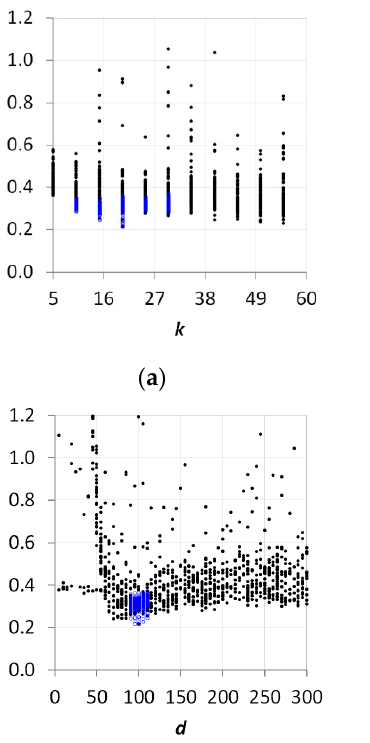
Table 1. Segmentation parameters, images acquired in arid and temperate periods.